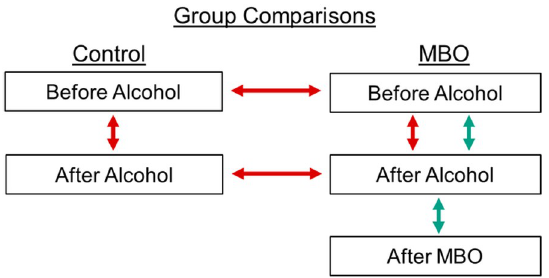
Fig 1. Analysis structure. Displays the design structure for all three experiments. Red arrows show the between group comparisons, comparing control and MBO participants before and after-alcohol. The green arrows highlight the design for the analysis of the MBO group data